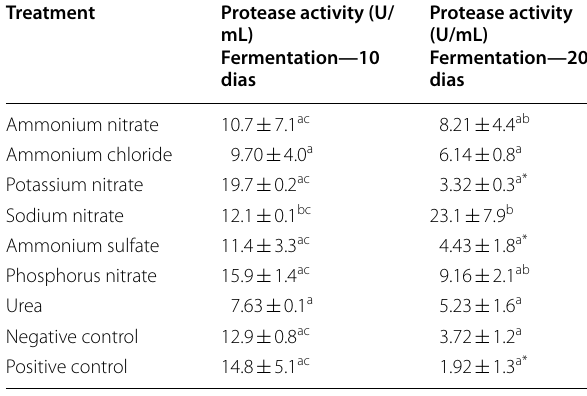
Table 3 Protease activity of Metarhizium robertsii ARSEF 2575 produced in medium supplemented with different inorganic salts and solid fermentation